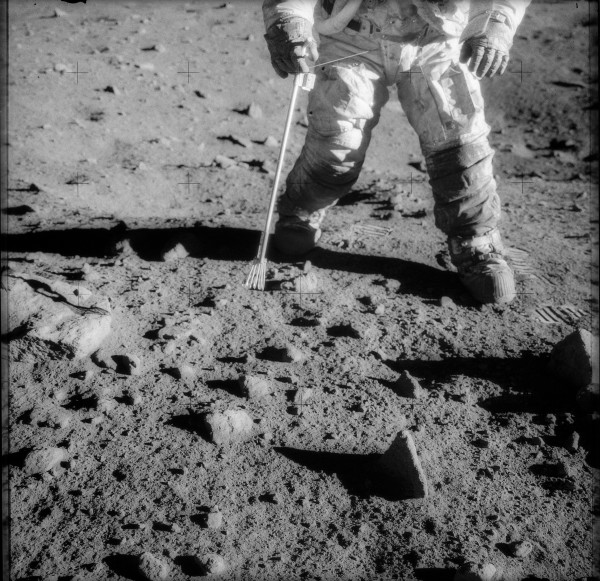
Apollo 12 spacesuit. An image depicting the lunar surface and dust collecting on the spacesuit of an Apollo astronaut.